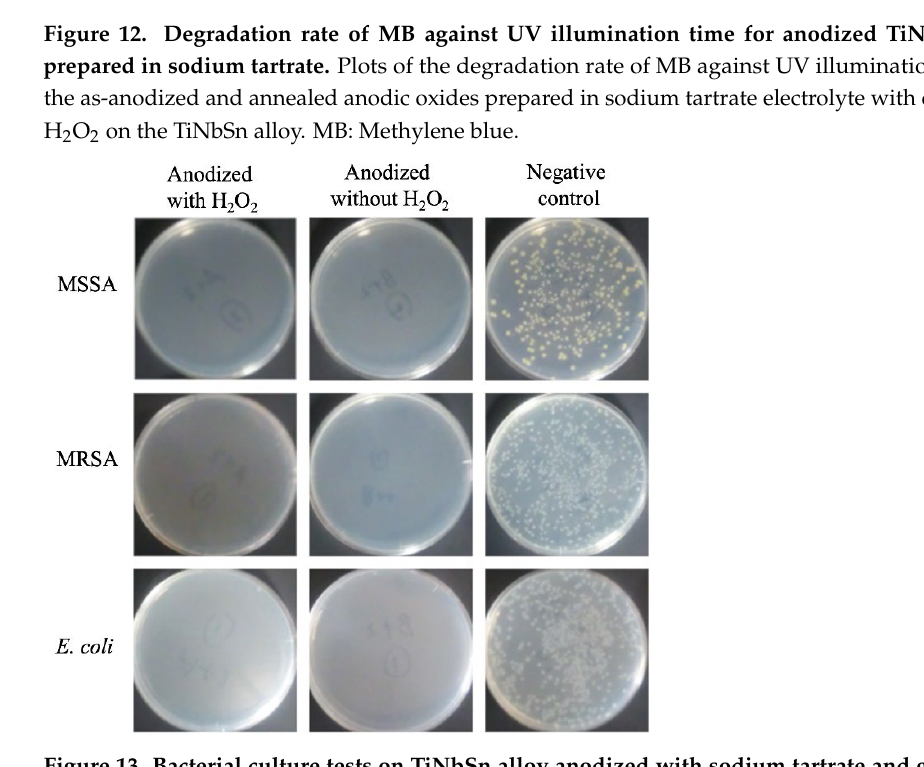
Figure 13. Bacterial culture tests on TiNbSn alloy anodized with sodium tartrate and glass plate. The photographs show the results of the culture of MSSA, MRSA, and E. coli washout solution after antibacterial tests with anodic oxides with H 2 O 2 and without H 2 O 2 and a glass plate under low-intensity ultraviolet light irradiation (0.21 mW/cm 2 ) for 8 h. MSSA: Methicillin-sensitive Staph-